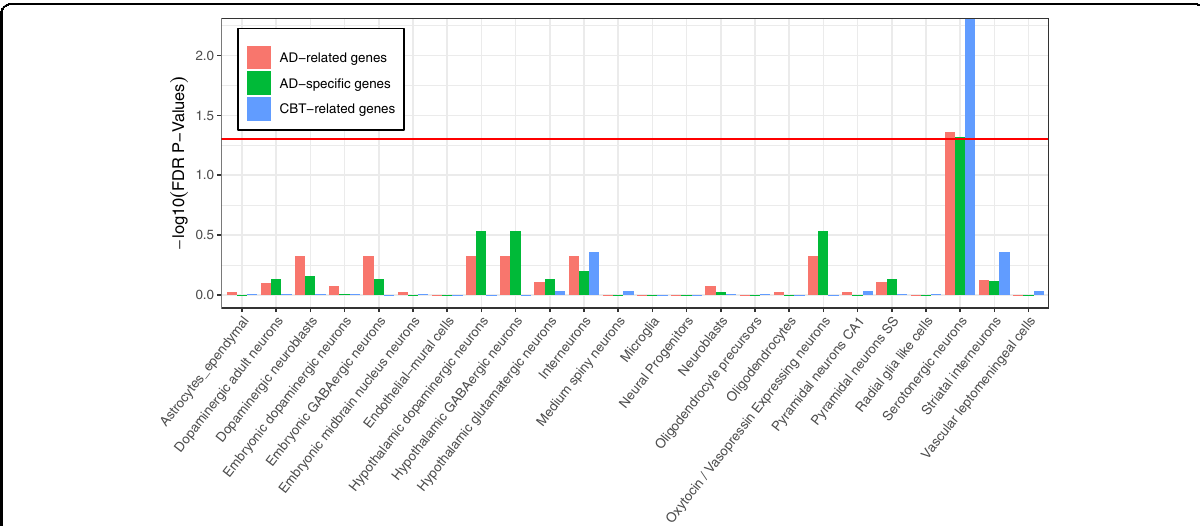
Fig. 2 Association of brain cell types and three gene panels. The red line indicates the signi fi cance threshold ( P < 0.05) after FDR adjustment. Histograms accessing the red line show that the serotonergic neurons are signi fi cantly associated with AD-related genes, AD-speci fi c genes, and CBT- related genes.